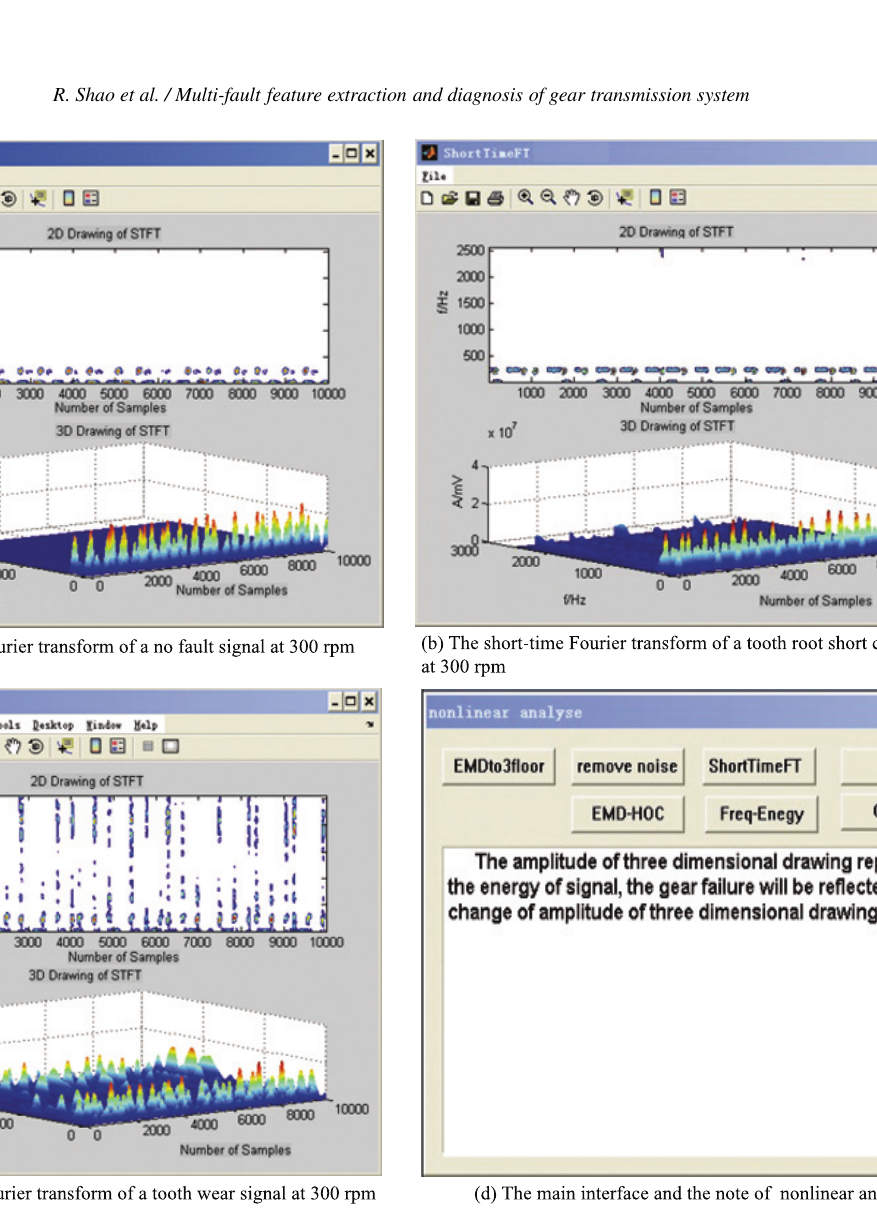
Fig. 15. The analysis interface of short-time Fourier